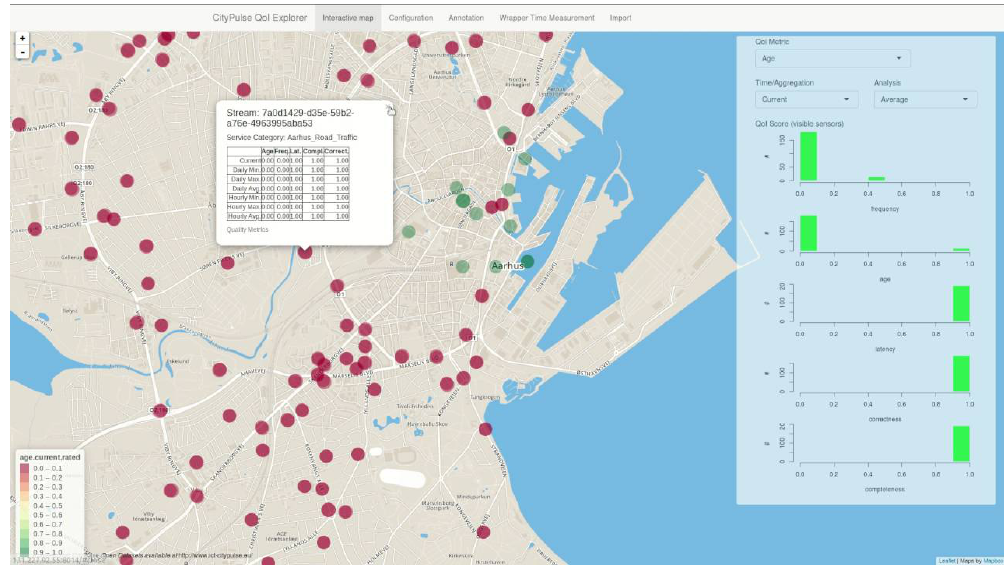
Figure 7. A snapshot of the CityPulse route planner demonstration (Source: